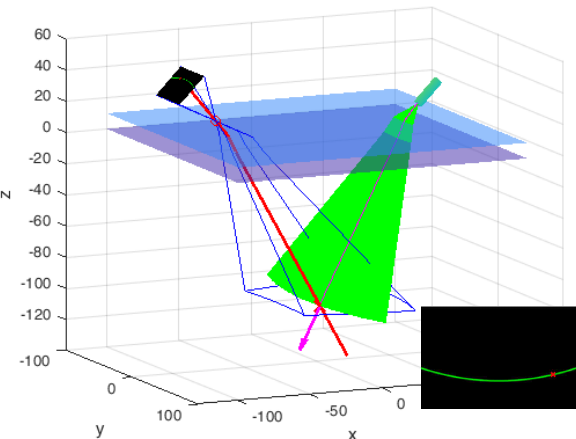
Figure 3: Intersection of image ray (red) and sub beam (magenta) of an image measurement on the line (small image). The two planes represent top and bottom of the glass interface between air and